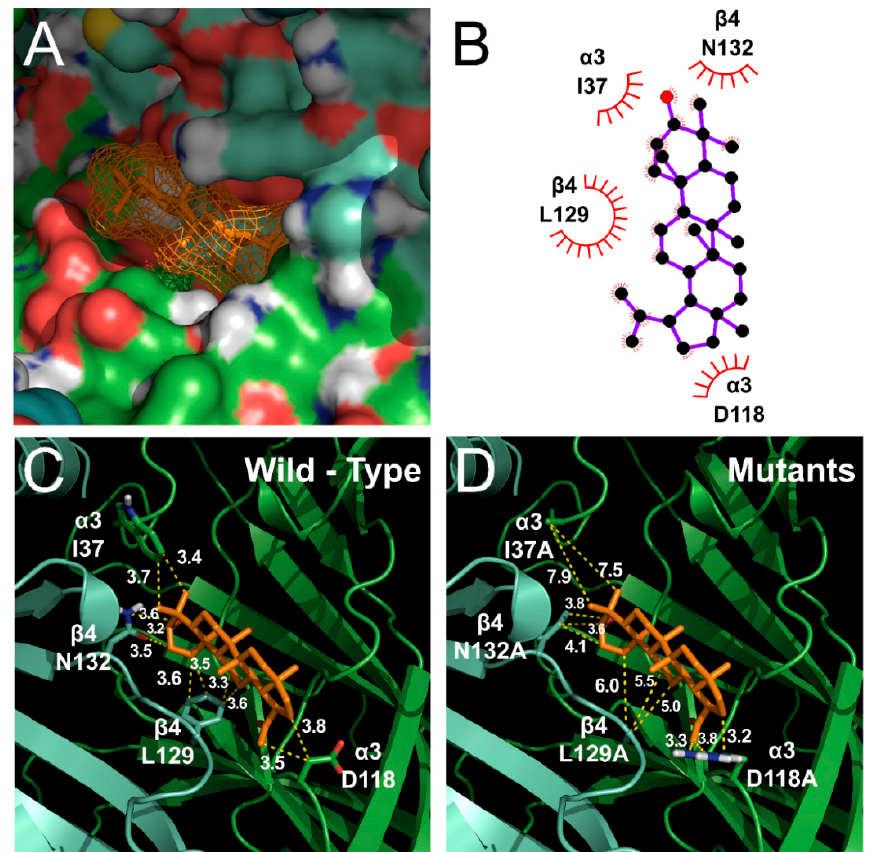
Figure 3. Computational molecular modeling of lupeol docked to α 3 β 4 nicotinic acetylcholine receptor. ( A , C ) Side views of docked lupeol in complex with nACh α 3 β 4 receptor. ( B , D ) Top view of docking model.